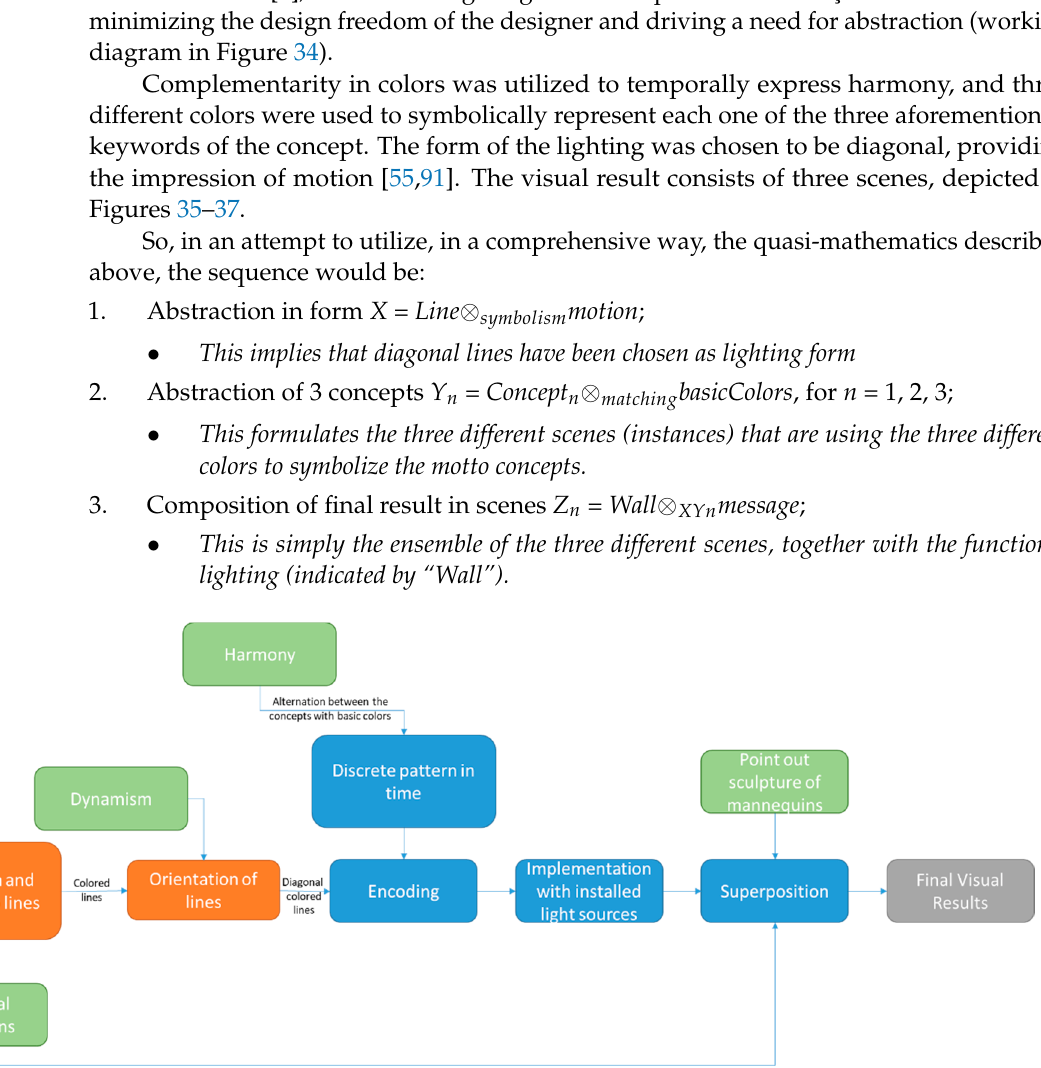
Figure 34. The working diagram for time variant lighting of glass case (tribute to Olympic games).